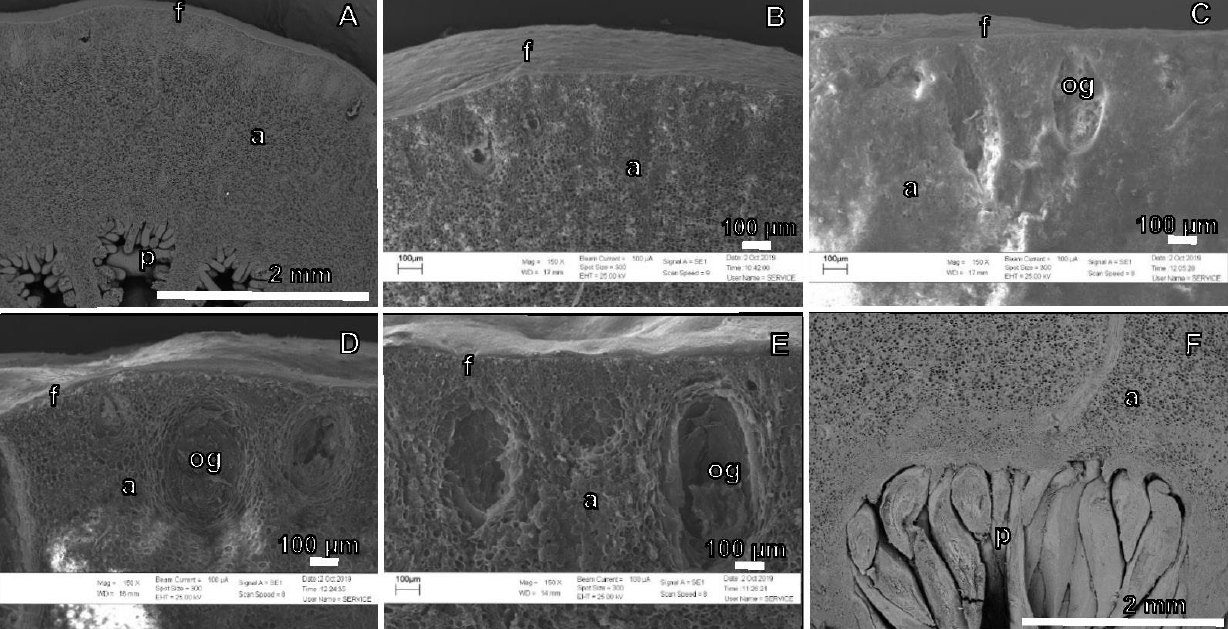
Figure 3. Scanning electron micrographs of orange fruit surfaces analyzed 30 ( A ) and 44 DAFB ( B ). Transmission electron micrographs of orange fruit epidermal cell wall and cuticle of fruits sampled 30 ( C ) and 44 DAFB ( D ). Arrows indicate the cuticle, and dark material underneath the cuticle cor- responds to pectin.